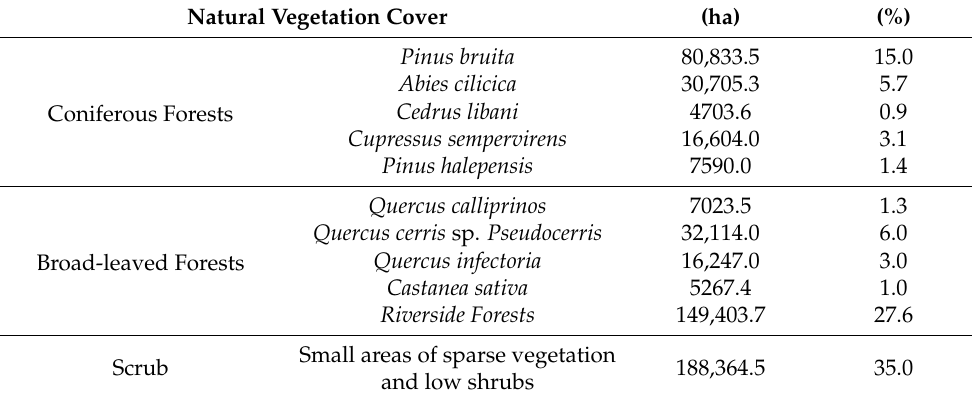
Table 1. Area of main natural forests in hectares (ha) and percentage share (%) in